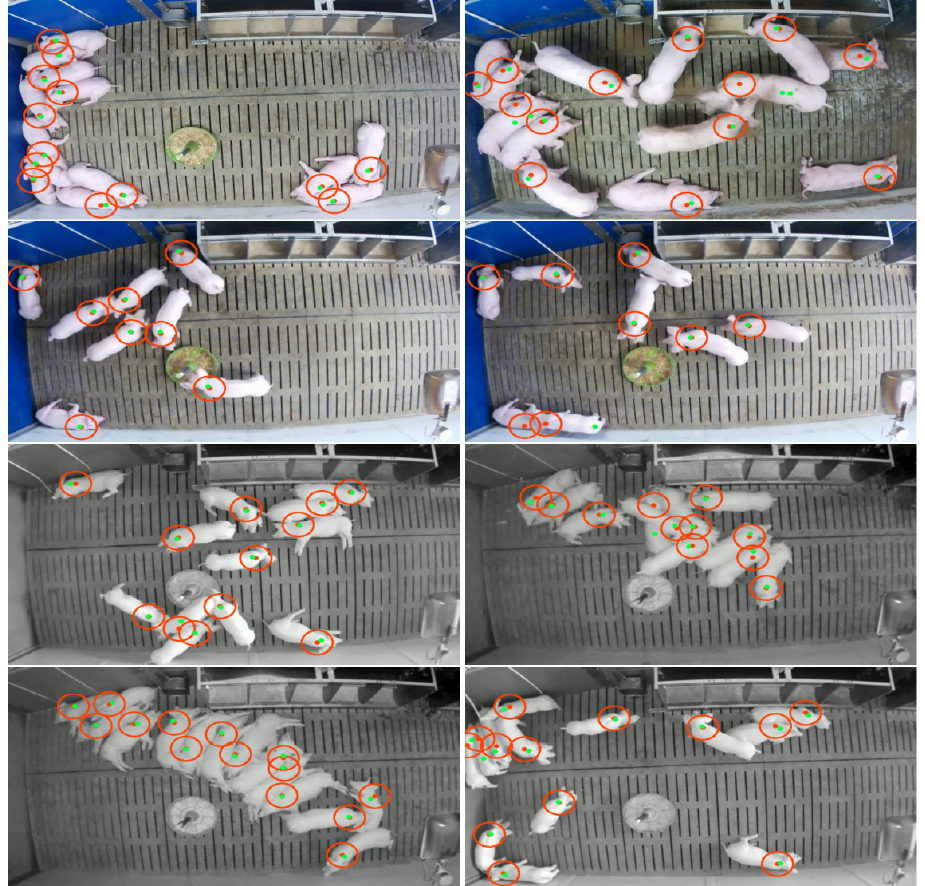
Figure 8. Example frames from the detection test set for day and night frames showing cases of a completely successful pig detection ( left column ) and cases in which at least one pig was not detected correctly ( right column ). A true shoulder point is highlighted by a red dot in the middle of the detection region (red circle). A green dot represents the predicted shoulder point from the